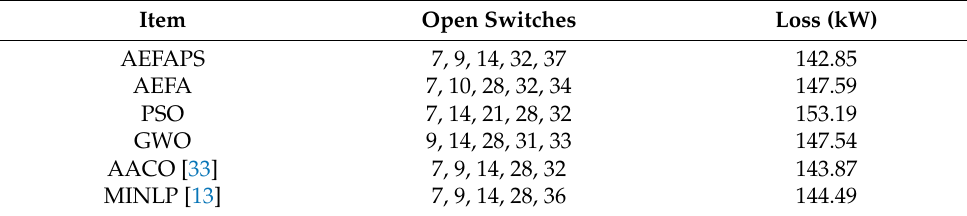
Table 10. Comparative results of the 33-bus network considering the active loss. Item Open